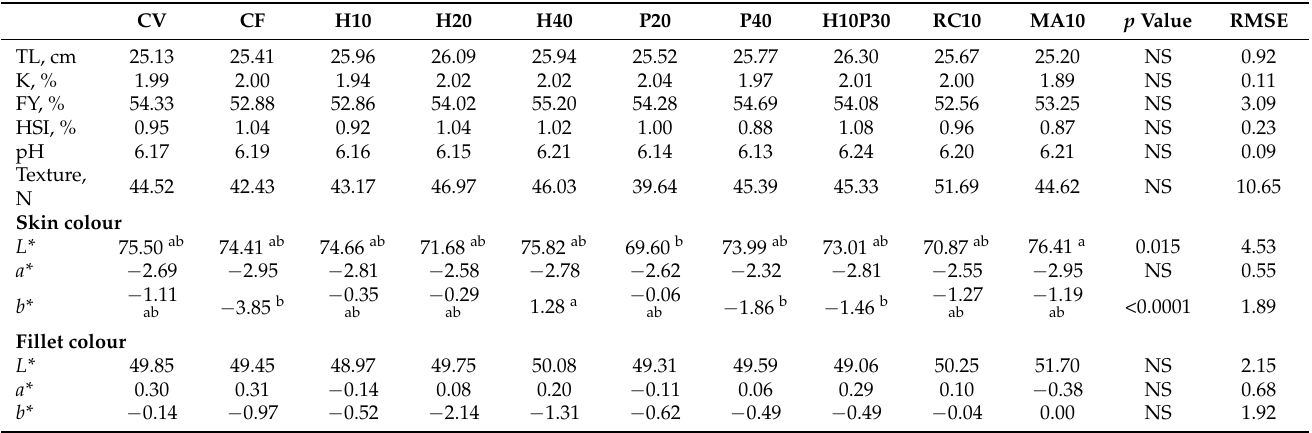
Table 4. Marketable indexes and physical characteristics of the fillets from gilthead sea bream ( Sparus aurata ) fed the experimental diets over 21 weeks.